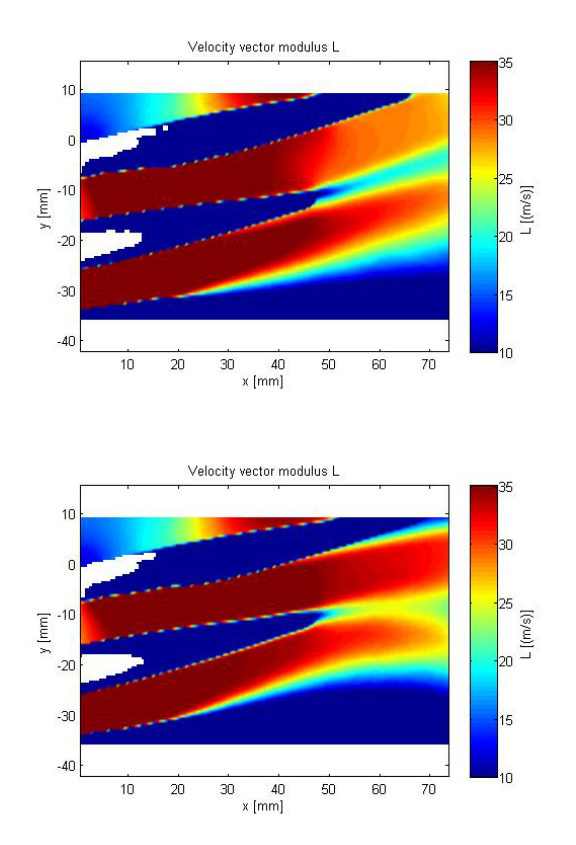
Fig. 10a, b, c, d. Mean phase velocity distribution and its STD value for excited regime (40 Hz and φ = 180° ) for compressor